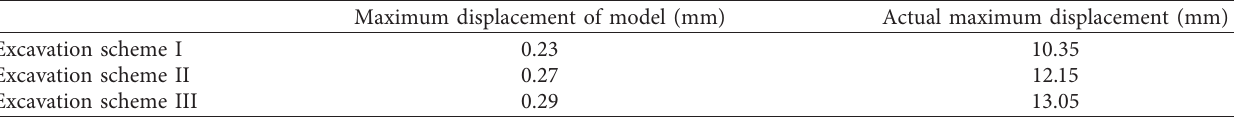
Table 6: Statistics of maximum